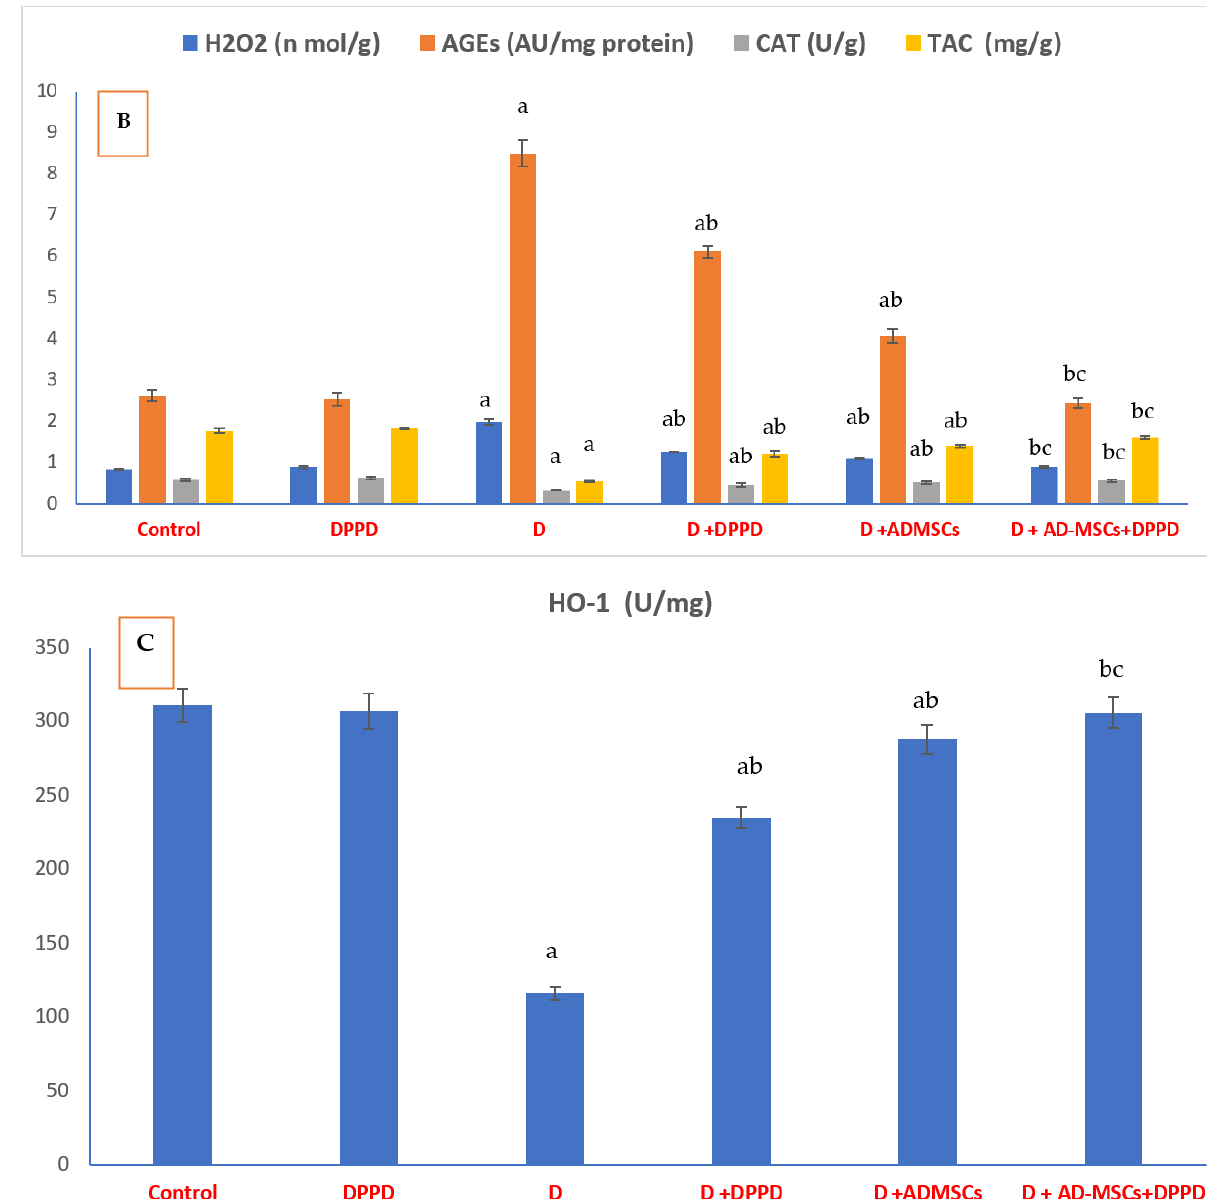
Figure 4. ( A ). Pancreatic oxidative stress (MDA and XO) levels and antioxidant markers (SOD and GST) levels. Values expressed as ± SEM ( n = 6). a, b & c are Significant differences ( p ≤ 0.05) compared to control, diabetic untreated and DPPD ‐ diabetic treated groups, respectively. % is the percent of change compared to the diabetic group. ( B ). Pancreatic oxidative stress (H 2 O 2 and AGEs) levels and antioxidant markers (CAT and TAC) levels. Values expressed as ± SEM ( n = 6). a, b & c are Significant differences ( p ≤ 0.05) compared to control, diabetic untreated and DPPD ‐ diabetic treated groups, respectively. % is the percent of change compared to the diabetic group. ( C ). Pancreatic heme ‐ oxy ‐ genase 1 oxidative stress levels. Values expressed as ± SEM ( n = 6). a, b & c are Significant differences ( p ≤ 0.05) compared to control, diabetic untreated and DPPD ‐ diabetic treated groups, respectively. % is the percent of change compared to the diabetic group. Figures 5 and S1a–c and Table S3 (Supplementary Information) illustrate marked rises in pancreatic inflammatory markers (CRP, TGF ‐β , CD95 + , and IL ‐ 6) %, compared to